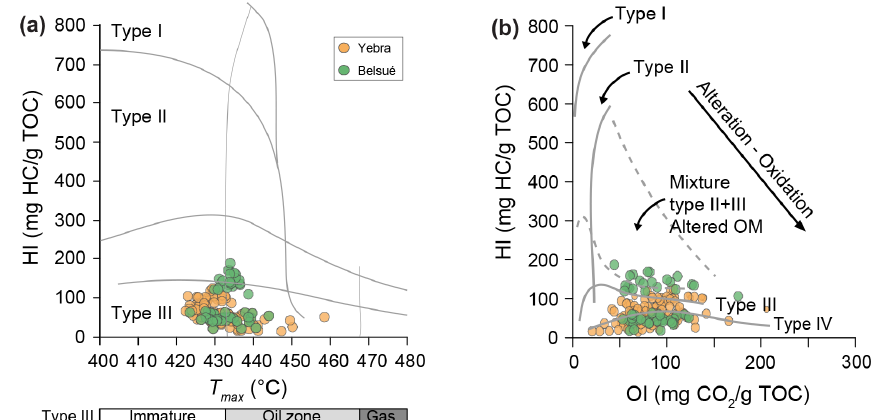
Figure 8. (a) The scatter plot of hydrogen index (HI) vs. T max values allows one to discriminate between the different kerogen types, (B), whereas the scatter plot of hydrogen (HI) vs. oxygen index (OI) allows one to assess the OM source and thermal maturity. Here we display the kerogen types (a) and the OM origin (b) from Yebra de Basa (orange) and Belsué (green). Samples with TOC values lower than 0.2wt% have been excluded. Reference lines for kerogen types and maturity after Espitalié